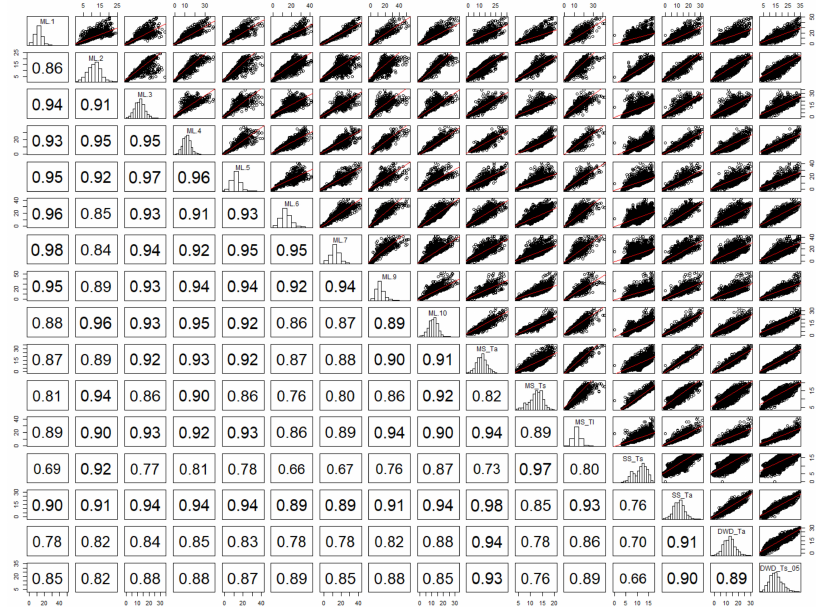
Figure A3. Spearman correlation matrix of hourly temperature averages (MS, SS, DWD) and single records (ML), re- spectively, including the surface-near measurements of the Micro-Logger (ML1 to ML10) and Medium Station (Tl), air temperature (Ta) of the Medium and Small Stations at “small clearing” and the official weather station (DWD) as well as soil temperature (Ts) in 5 cm depth. The lower triangle shows the coefficient of determination ( R 2 ), the upper triangle the scatterplots and linear regression fit lines (red) and the diagonal the